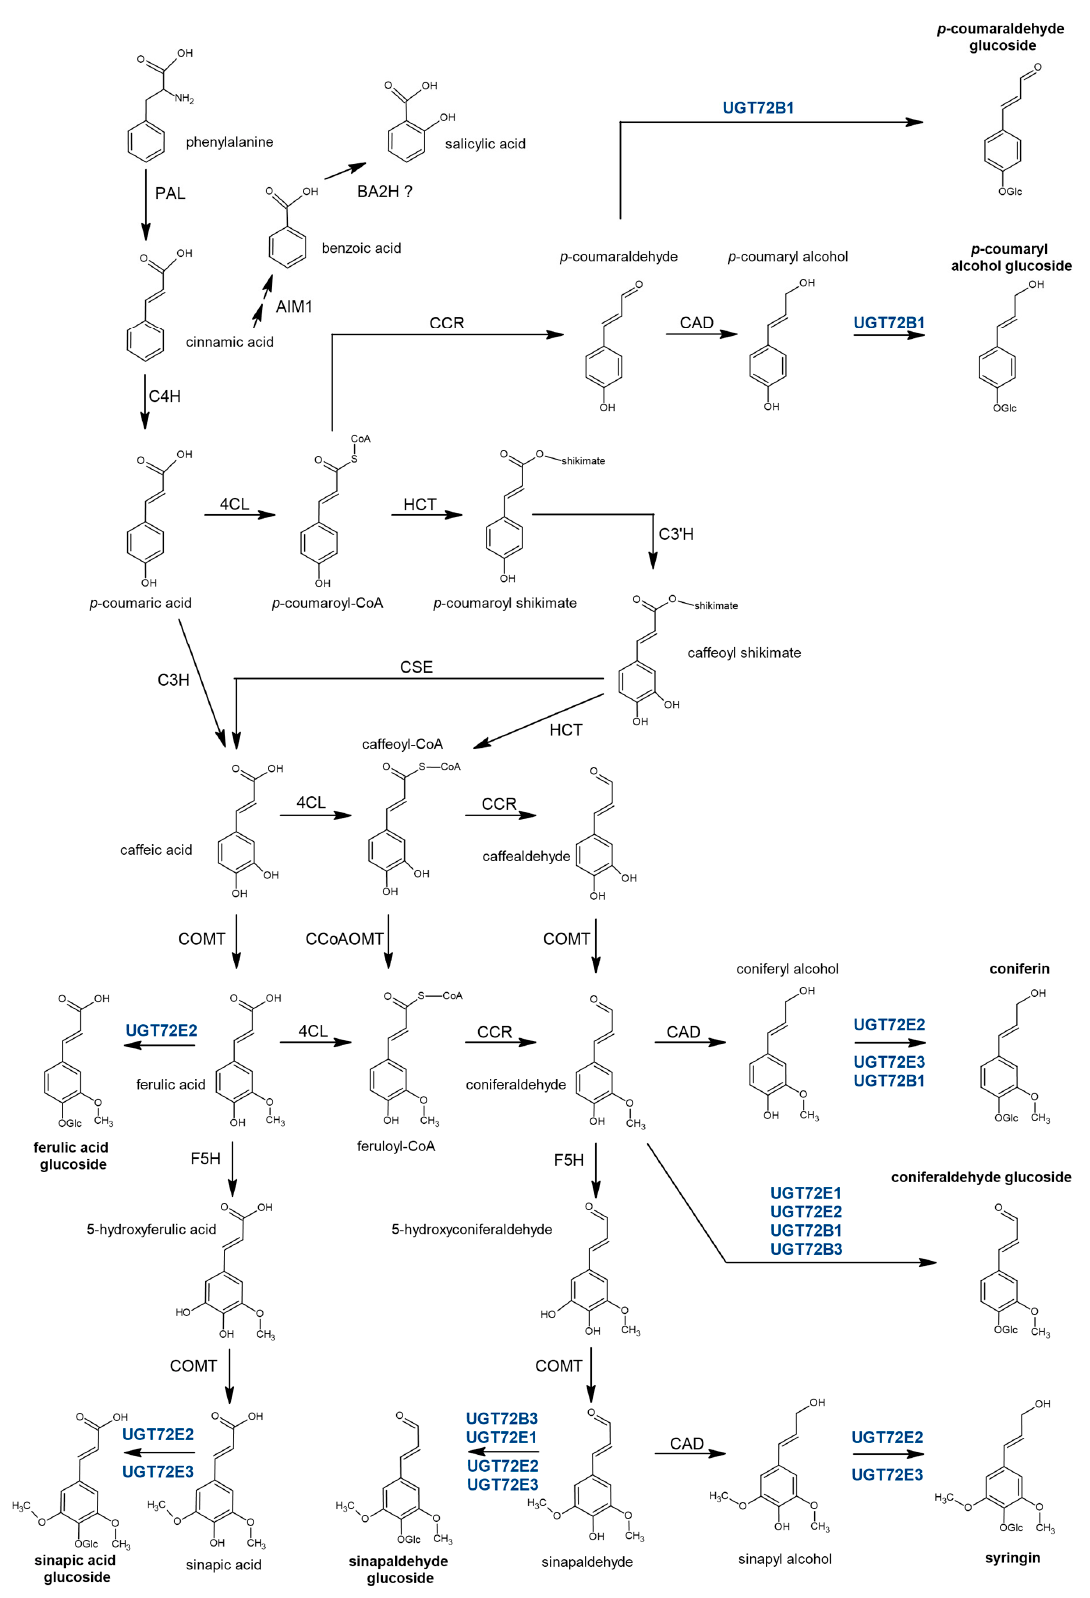
Figure 1. The monolignol biosynthetic pathway with associated glycosylated products and uridine diphosphate glucosyltransferases (UGT) catalyzing in vitro this glycosylation in Arabidopsis